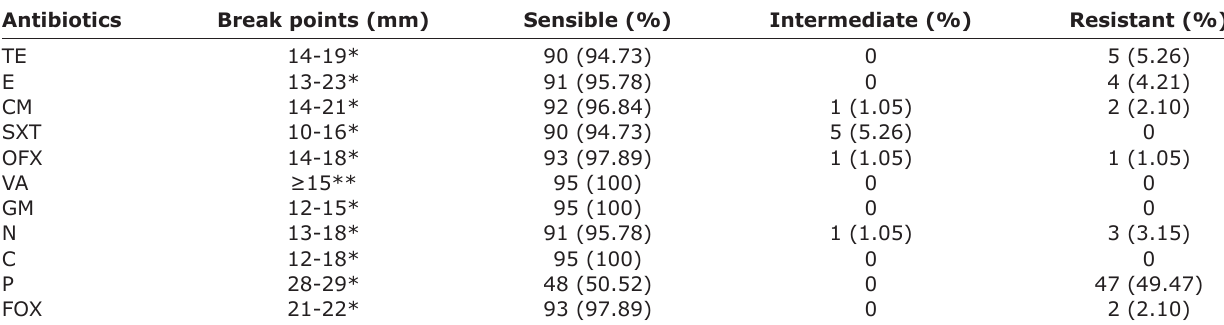
Table-3: Susceptibility of S. aureus isolates to tested antibiotics.